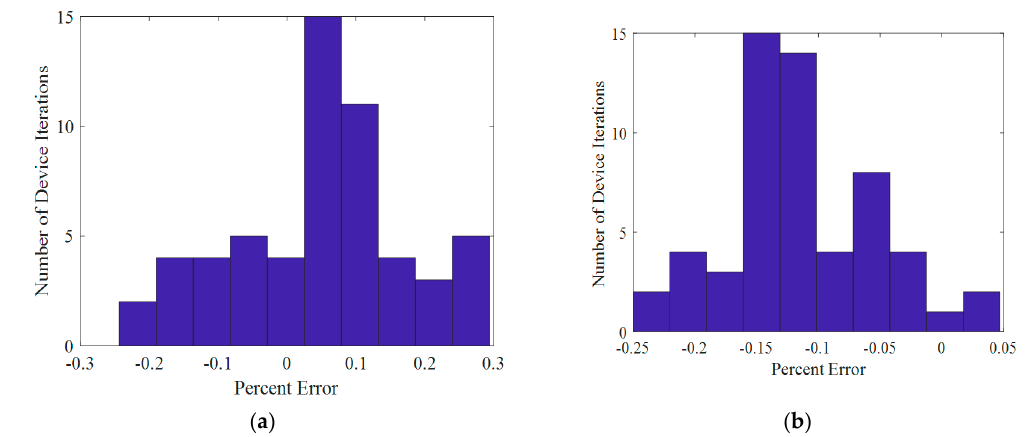
Figure 4. Histogram of the extraction error for: ( a ) length for all devices; ( b ) width for all devices.